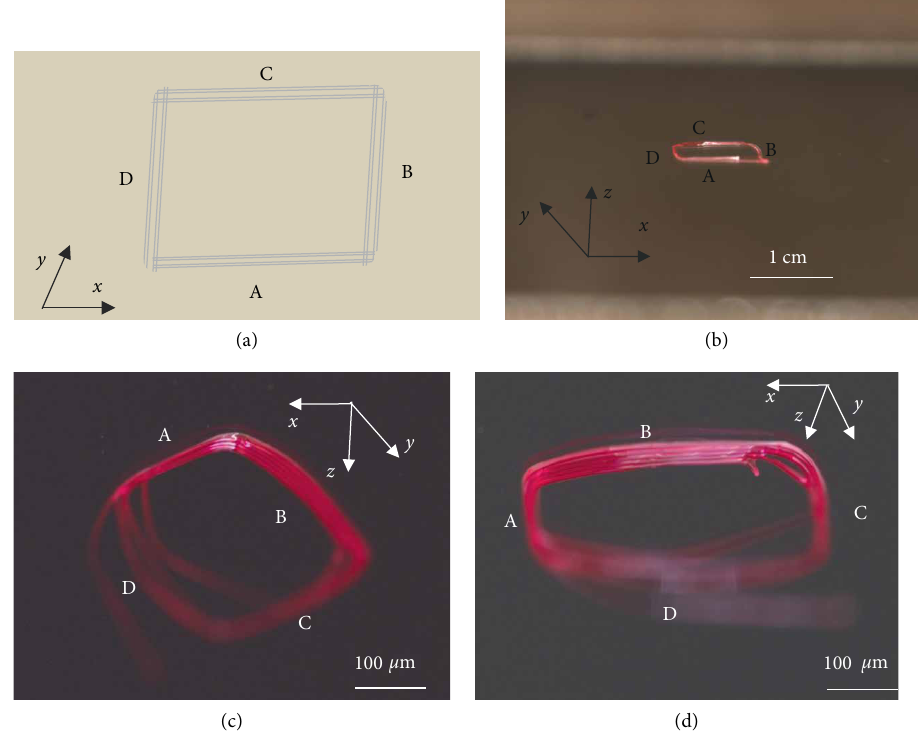
Figure 6: (a) Schematic outline of the cubic microstructure. (b) Stereomicroscope image of the complete architecture where every side was named C A B D ( , , , ). (c) Changing the point of view and titling the sample during the observation it is possible to analyse the layered angle constructed between two adjacent sides. (d) One of the side of the microstructure (side